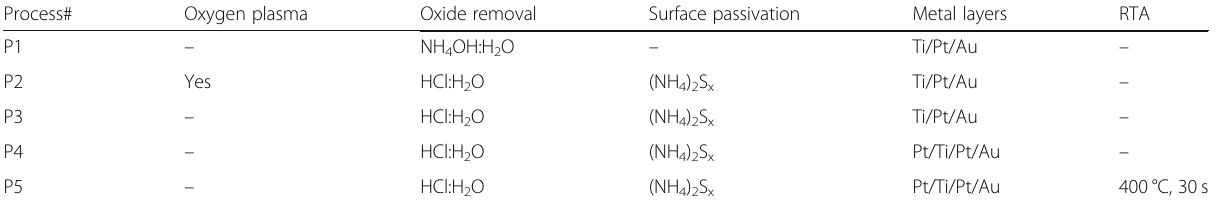
Table 1 Fabrication details of electrical contacts used for transport characterization of Be-doped GaAs NWs Process#